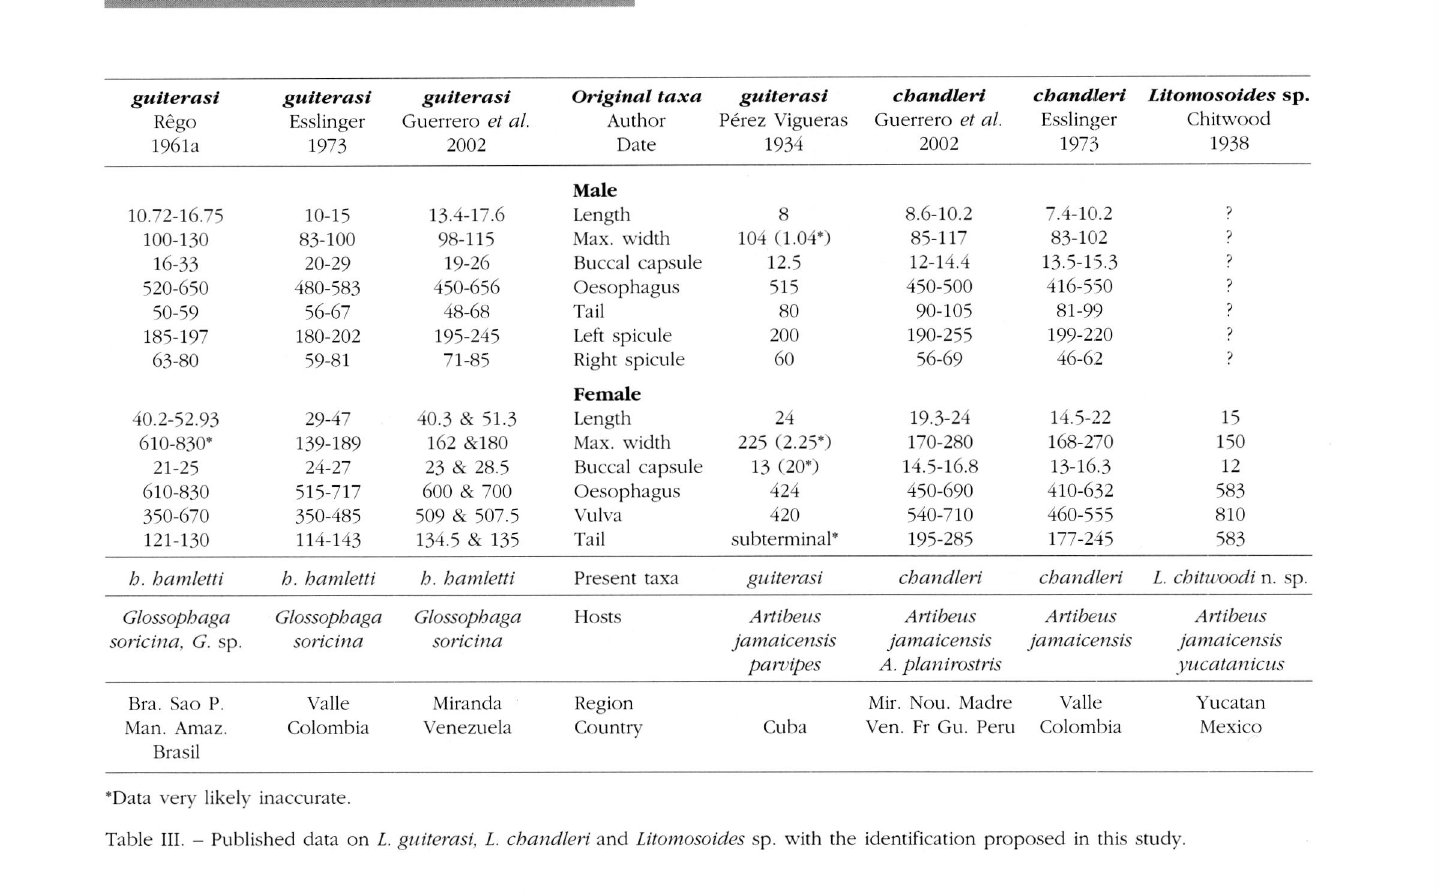
Table III. - Published data on L. guiterasi. L. chandleri and Litomosoides sp. with the identification proposed in this